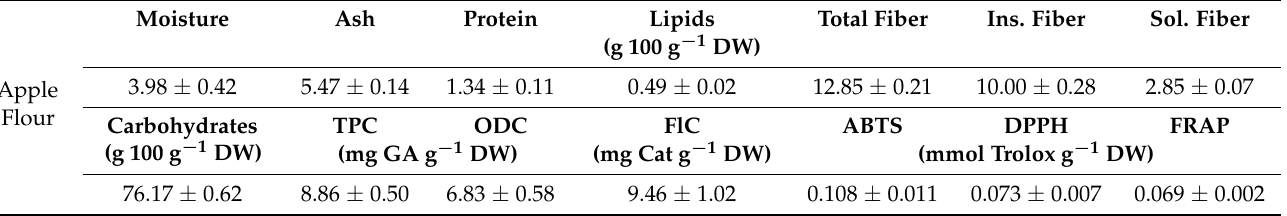
Table 2. Apple flour characterization: nutritional profile, bioactive compounds, and antioxidant